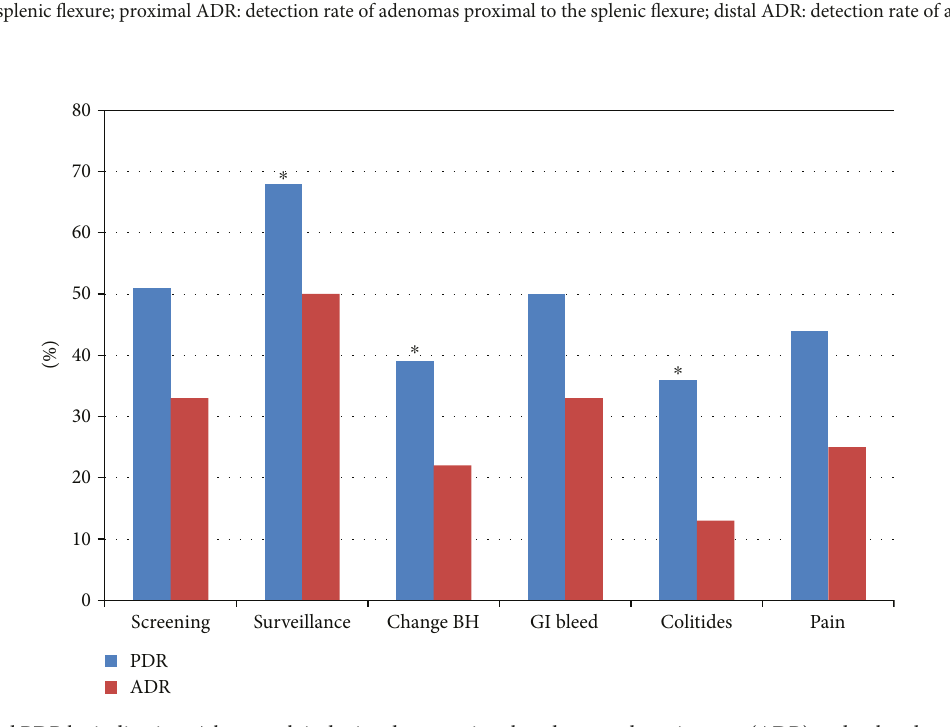
Figure 1: ADR and PDR by indication. A bar graph is depicted comparing the adenoma detection rate (ADR) and polyp detection rate (PDR) for colonoscopies performed for the various indications of screening, surveillance, change in bowel habit, GI bleeding (GIB), colitides, and pain. The legend should state the following: ∗ signi fi cantly di ff ers from screening PDR and ADR. Surveillance ADR and PDR, p < 0 001 ; change in bowel habit ADR and PDR, p < 0 001 ; colitides PDR, p = 0 002 , and ADR, p < 0 001